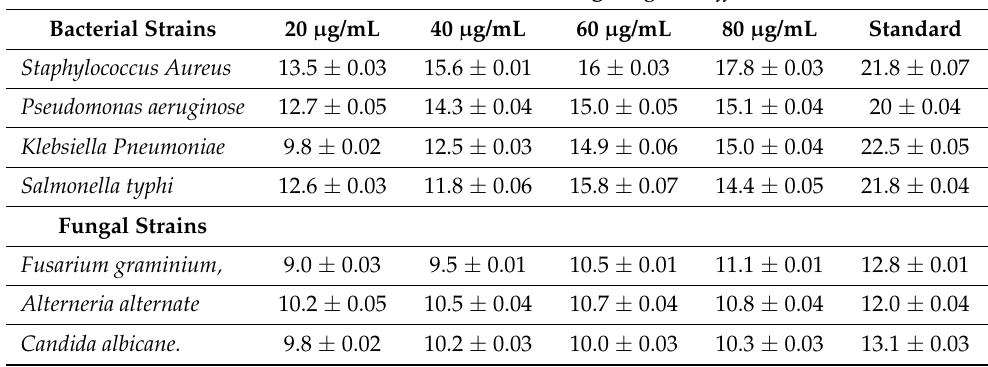
Table 1. Concentration of zone of